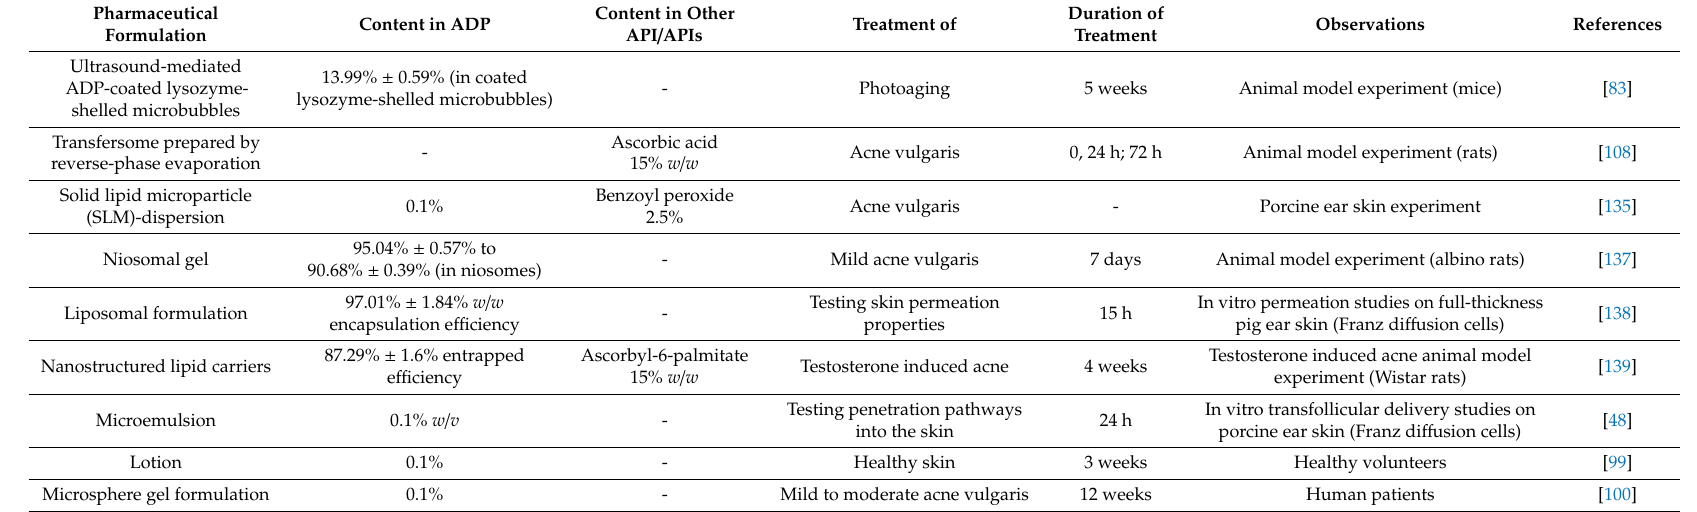
Table 7. Novel topical pharmaceutical forms with adapalene (ADP) alone or in combination with other active pharmaceutical substances